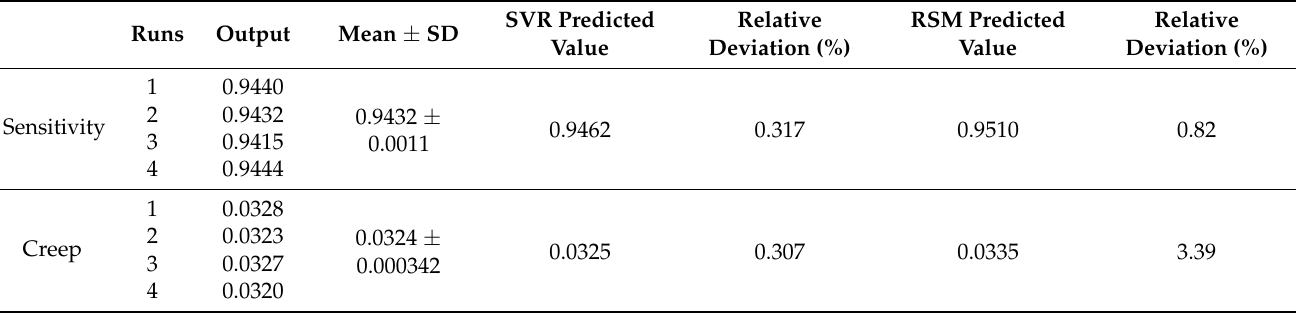
Table 8. Verification of experiment